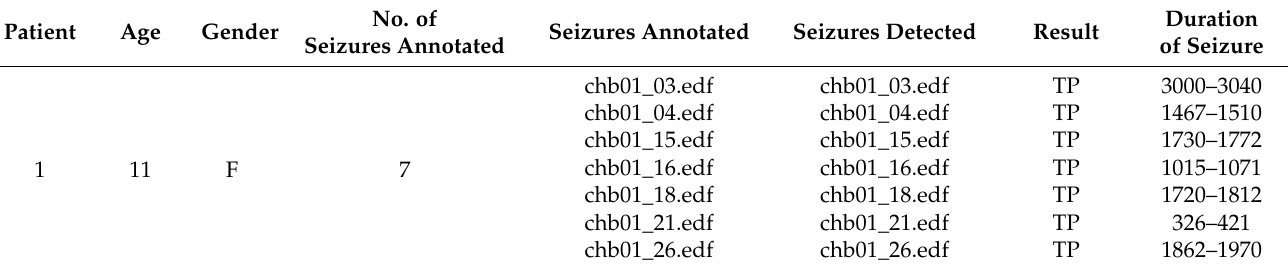
Table 2. Algorithm test result for Patient 1, dataset